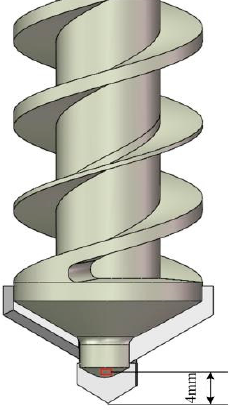
Figure 5. Selection of temperature measuring point of drill tool.